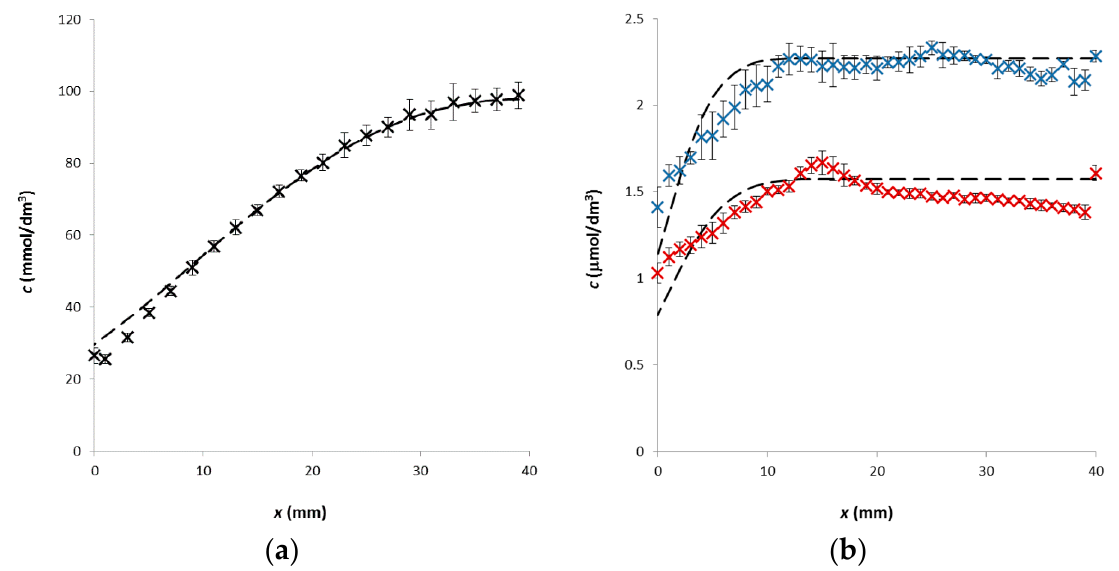
Figure 3. The concentration profile of Cu(II) ions in AG–LEHA hydrogel after 40 h from the start of release ( a ), and the concentration profiles of MB (blue) and RH (red) in AG–LEHA hydrogel after 168 h from the start of release ( b ) fitted by Equation (8) – dashed curves.